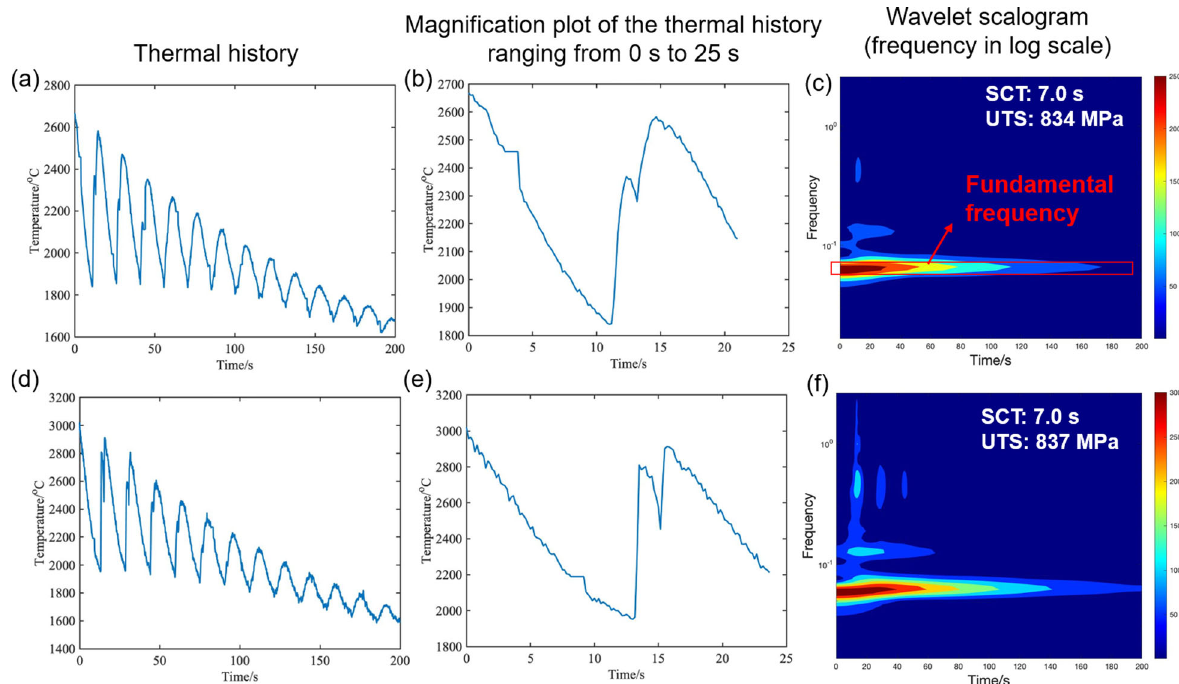
Fig. 7 Capability of wavelet transform on capturing the nature of thermal histories. In melt pool control mode DED, laser power is adjusted frequently to stabilize melt pool size, which however might lead to local fl uctuation of thermal history and resulting mechanical properties. This work demonstrates this effect clearly using machine learning approach. The fi rst row for a – c shows the results for the right bottom of wall #4 (without melt pool control). a A 200 s thermal history, b a sub-range thermal history ranging from 0 s to 25 s, c the wavelet scalogram of the 200 s thermal history. The second row for d – f shows the results for the right bottom of wall #10 (with melt pool control). d A 200 s thermal history, e a sub-range thermal history ranging from 0 to 25 s, f the wavelet scalogram of the 200 s thermal history.